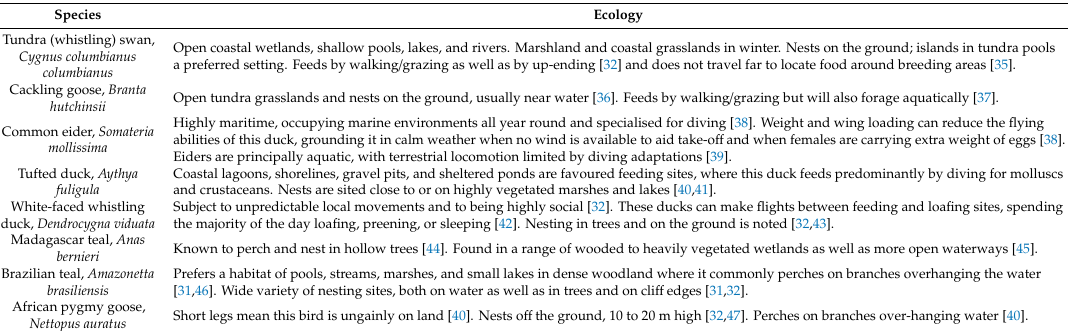
Figure 2. Anseriformes species that are often seen to perch (right of the diagram) compared to those that do not perch (left of the diagram). Measurement of time spent perching or sitting off the ground could guide management practices around flight restraint. The whistling swan (top left) has a wild ecology that suits it more to containment by flight restraint compared to the African pygmy goose (bottom right), whose evolutionary adaptations enable it to perch and nest off the ground, based on these bird’s ecological differences as outlined in Table 1. Table 1. Examples of ecological information used to understand a species’ needs for being o ff the ground in captivity, focusing on the Anseriformes depicted in Figure